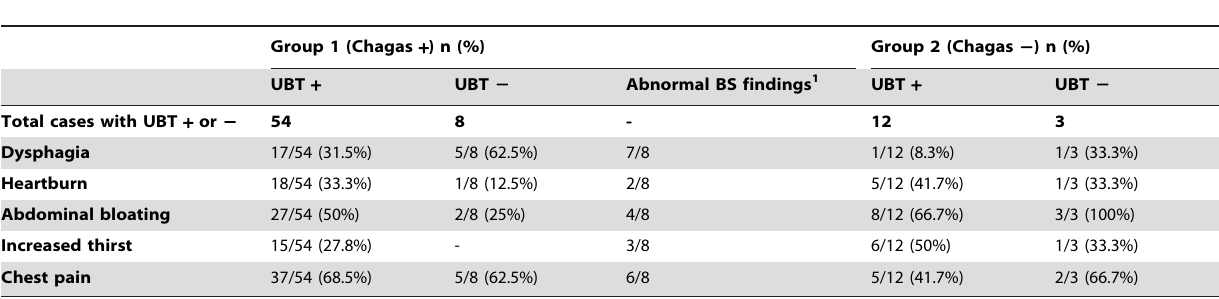
Table 2. Symptoms related to H. pylori infection and analysis of symptoms shared with T. cruzi